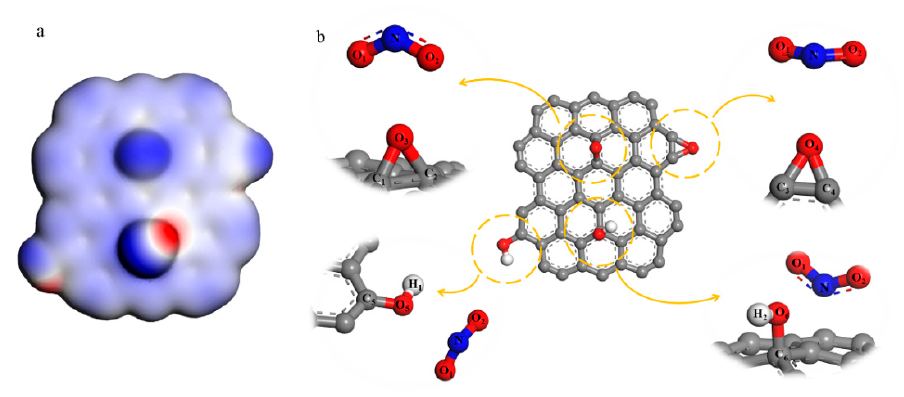
Figure 1. ( a ) Electrostatic potential diagram of simplified graphene oxide (GO) model; ( b ) the reaction between NO 2+ and hydroxyl and epoxy groups both in the surface and the edge. MD was used to simulate the hydrophilic of GO and NGO. 500 water molecules were put into a cell (33.44 × 33.44 × 33.44 Å 3 ) and the GO and NGO models were established in